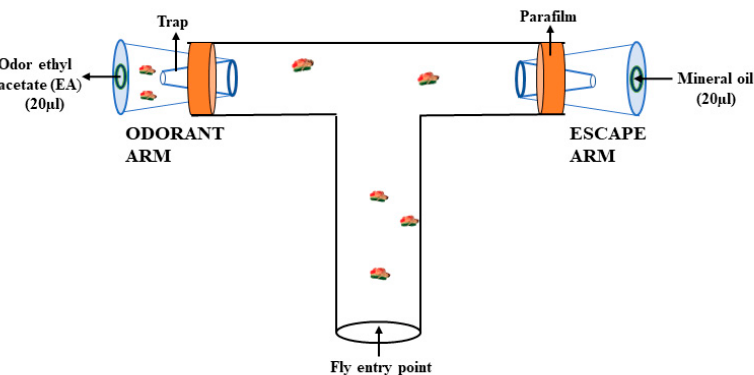
Figure 2. An illustration of an experimental T-maze testing assay designed for adult Drosophila flies. The two arms of the T-tube, the escape arm, and odorant arm are attached to the traps that do not allow the flies to change their choice, once they enter the trap. Parafilm helps in avoiding flies from being trapped in between the space and tight fitting of the trap with the T-tube. One trap contained 20 µ L of mineral oil (solvent), while the other contained 20 µ L of ethyl acetate odor of 10 − 5 dilution in mineral oil.